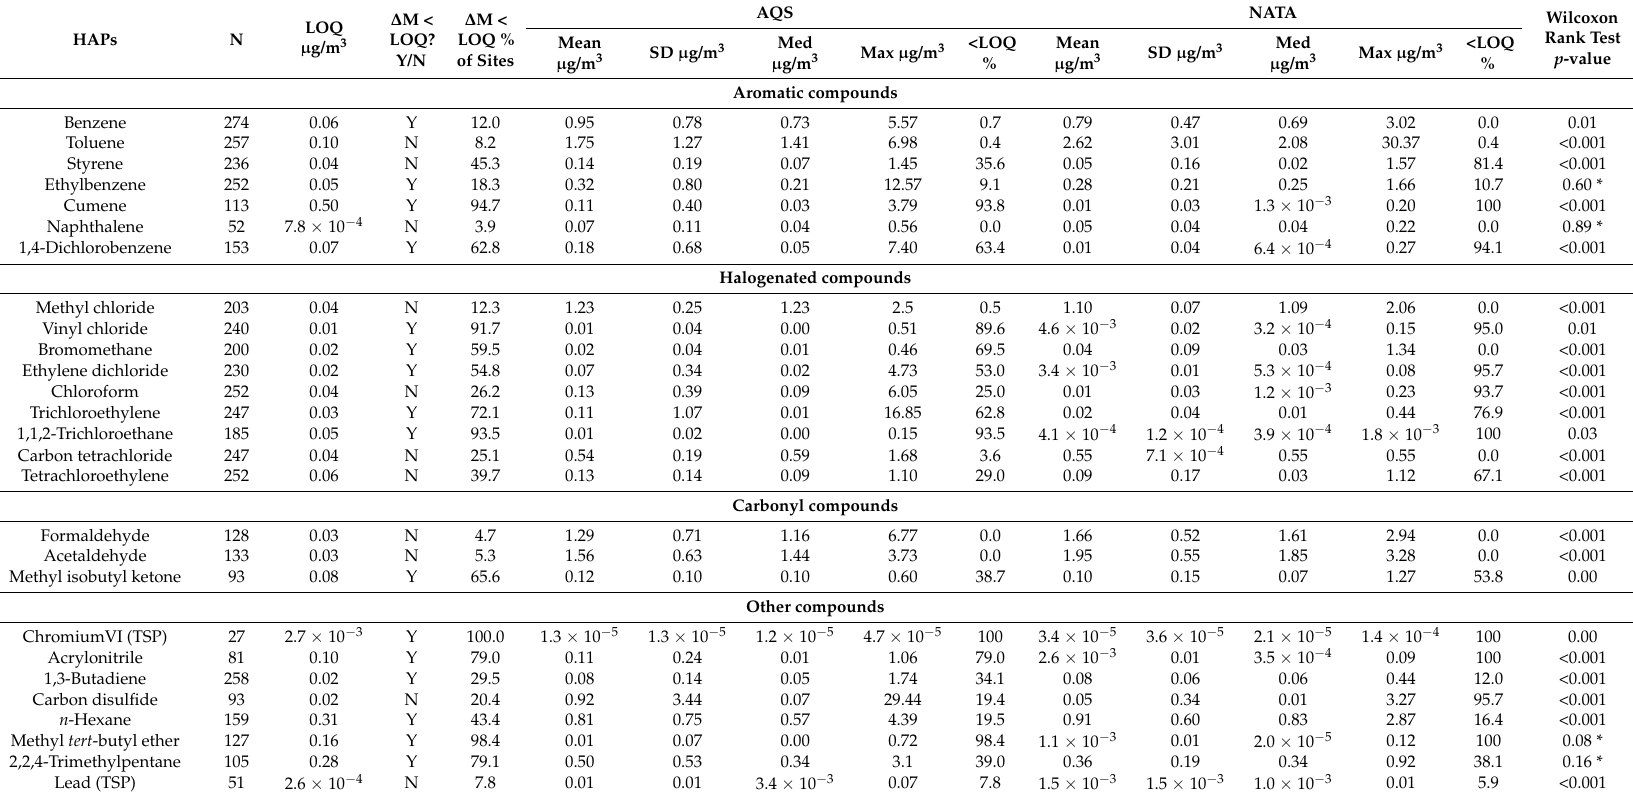
Table 2. National statistics of HAP concentrations measured by AQS and modeled by